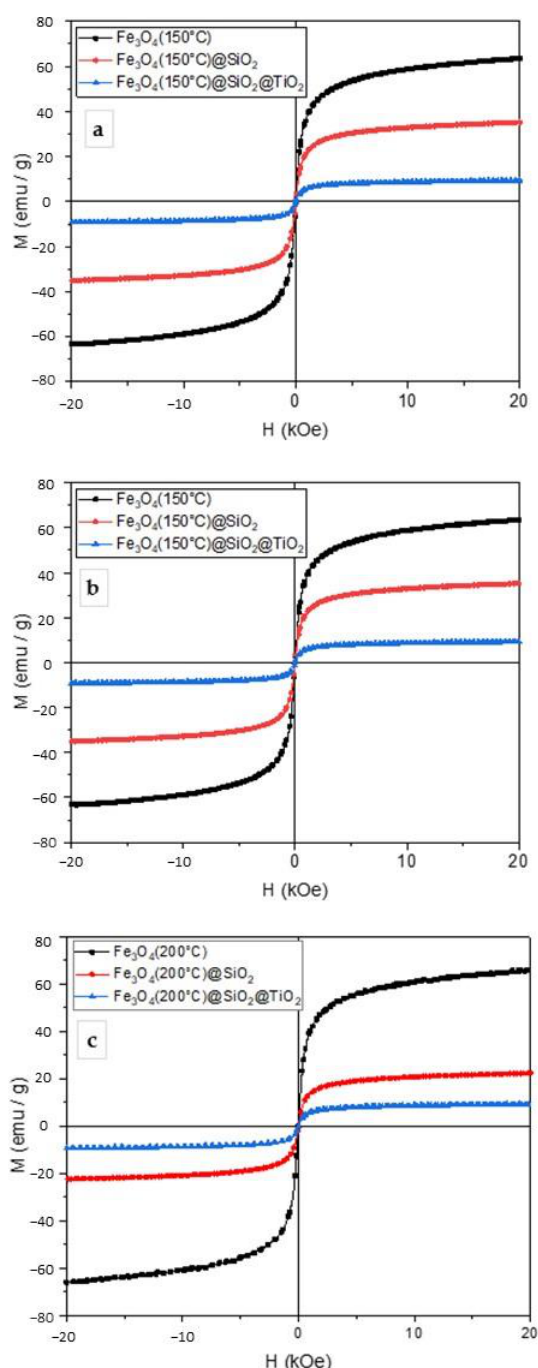
Figure 3. Magnetization curves of Fe 3 O 4 , Fe 3 O 4 /SiO 2 , and Fe 3 O 4 /SiO 2 /TiO 2 nanoparticles synthesized by the microwave-assisted method at 100 °C ( a ), 150 °C ( b ), and 200 °C ( c ). The texture and morphology of the core–shell nanocomposites were investigated using SEM analysis with different magnifications, shown in Figure 4. The magnetite nanoparticles, shown in Figure 4a–c, had a disordered surface texture. The presence of agglomerates was due to the small size of particles and their magnetization. The surface displayed